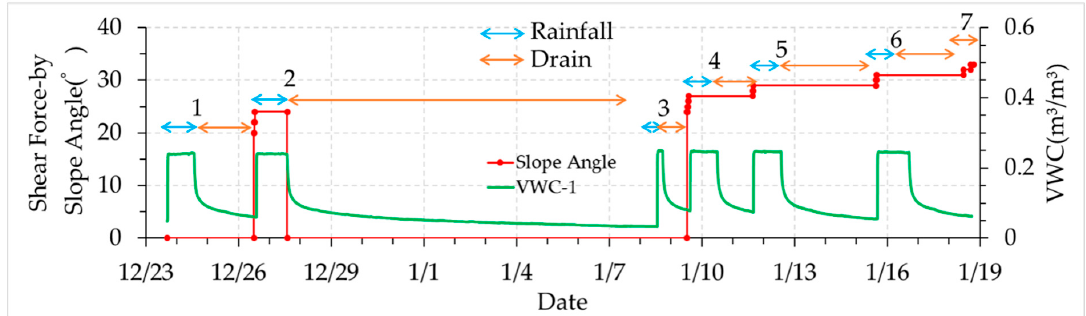
Figure 10. Test cases in the test procedure with a time serial.